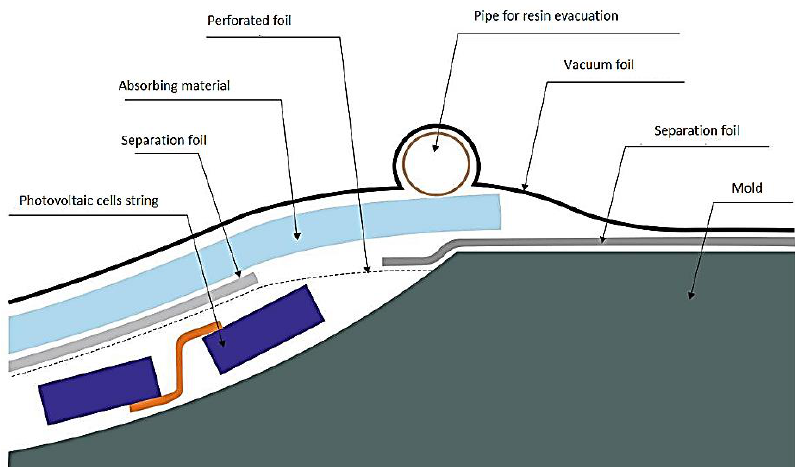
Figure 7. Technology for ultra-light wing with embedded photovoltaic cells fabrication.